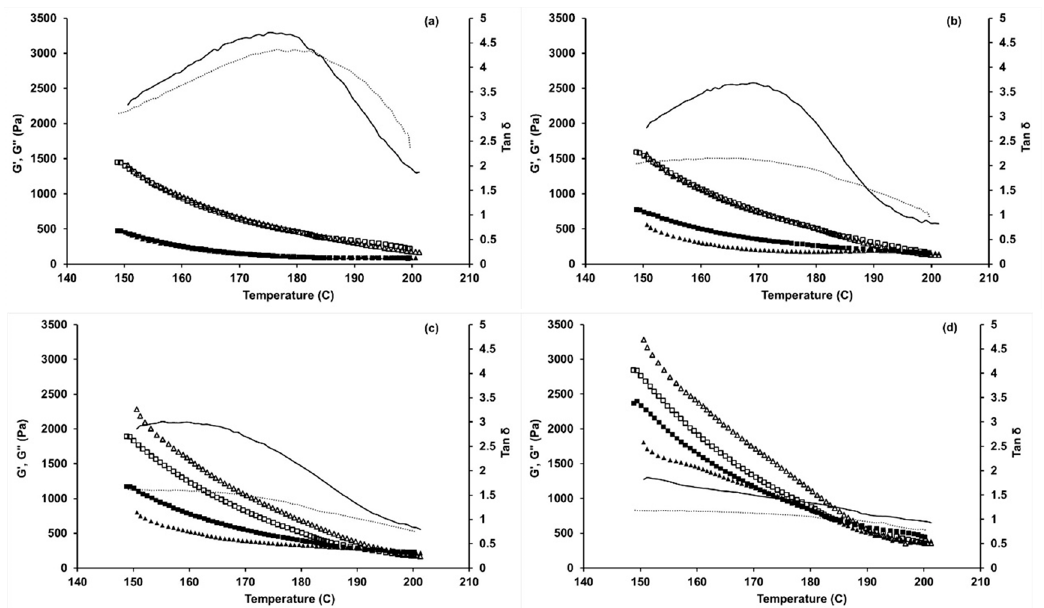
Figure 5. Storage modulus (G’), loss modulus (G ′′ ) and loss tangent (tan δ ) of ( a ) PAN; ( b ) PAN-10%wt BL; ( c ) PAN-20%wt BL; and ( d ) PAN-30%wt BL blends as a function of temperature between 150 and 200 °C. ▲ -G’ (heating); ■ -G’ (cooling); Δ -G ′′ (heating); □ -G ′′ (cooling); ▬ tan δ (heating); ▪▪▪ tan δ (cooling). Table 2. The slope of the Han plot at different temperatures and BL blending with PAN in [BMIM]Cl. Polymer Solution Slope of Han Plot (Dimensionless)